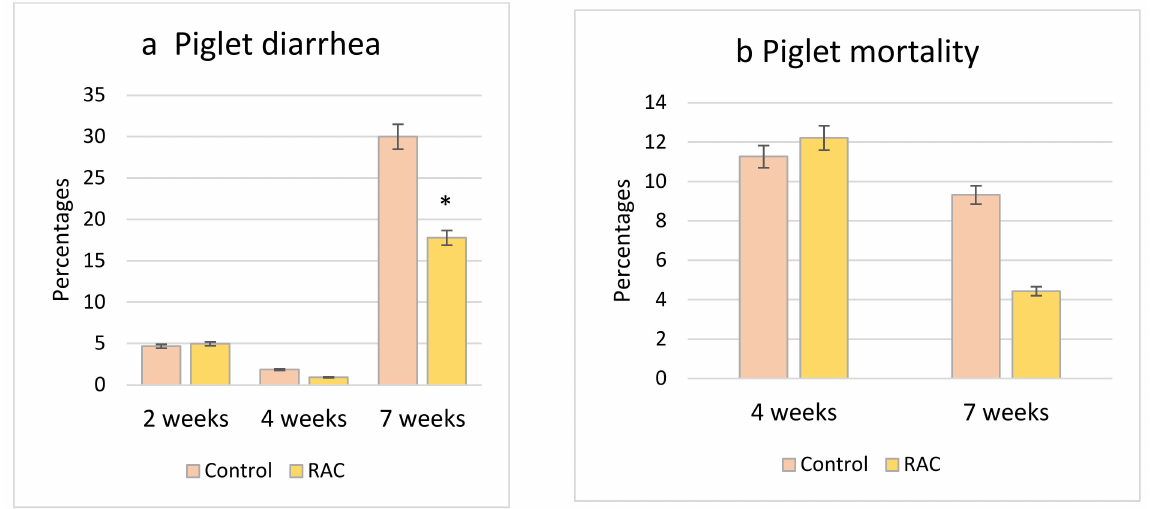
Figure 4. ( a ) Piglet diarrhea at two weeks, four weeks and seven weeks of age; ( b ) Piglet mortality rate at four weeks and seven weeks of age. * p <